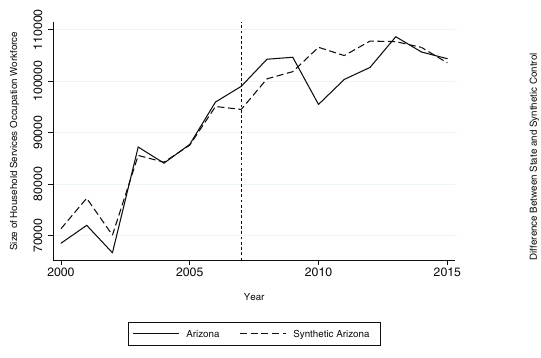
Figure 12 Size of household service occupations